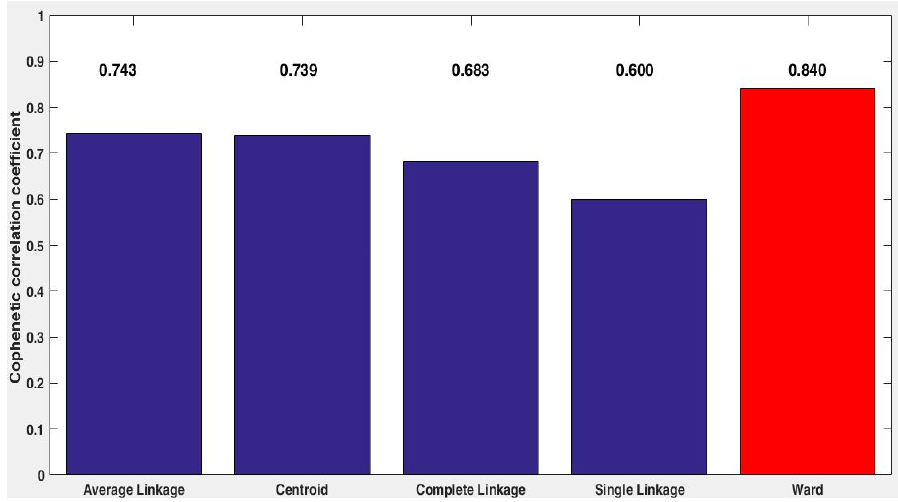
Figure 11. The cophenetic correlation coefficient associated with the clustering hierarchical methods. Table 6. The results of the profiling process.